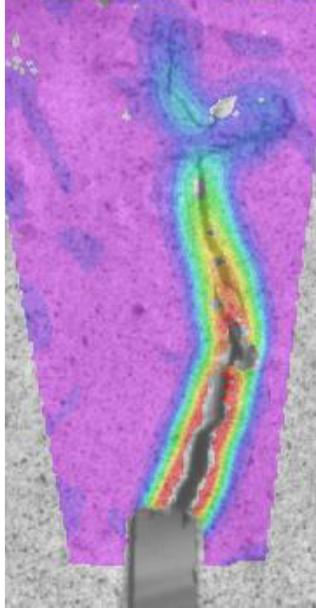
Figure 14. Crack generated in one of the specimens during the bending test.